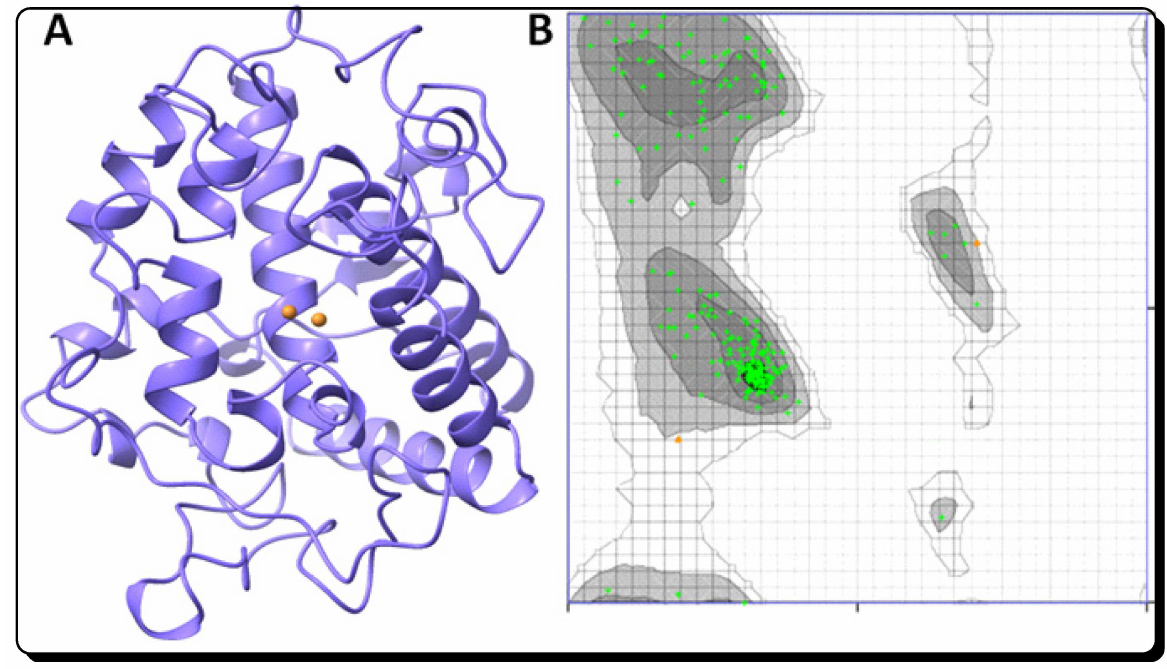
Figure 5. The structure of bacterial tyrosinase PDB ID 3NM8 ( A ) and its Ramachandran graph ( B